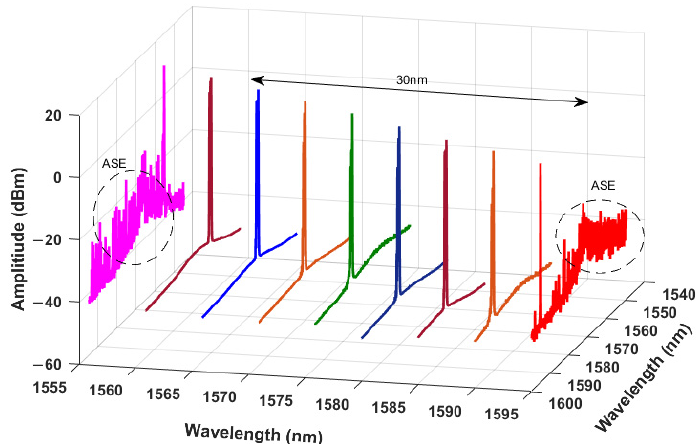
Figure 5. Tuning range of the generated sextuple Stokes signals.